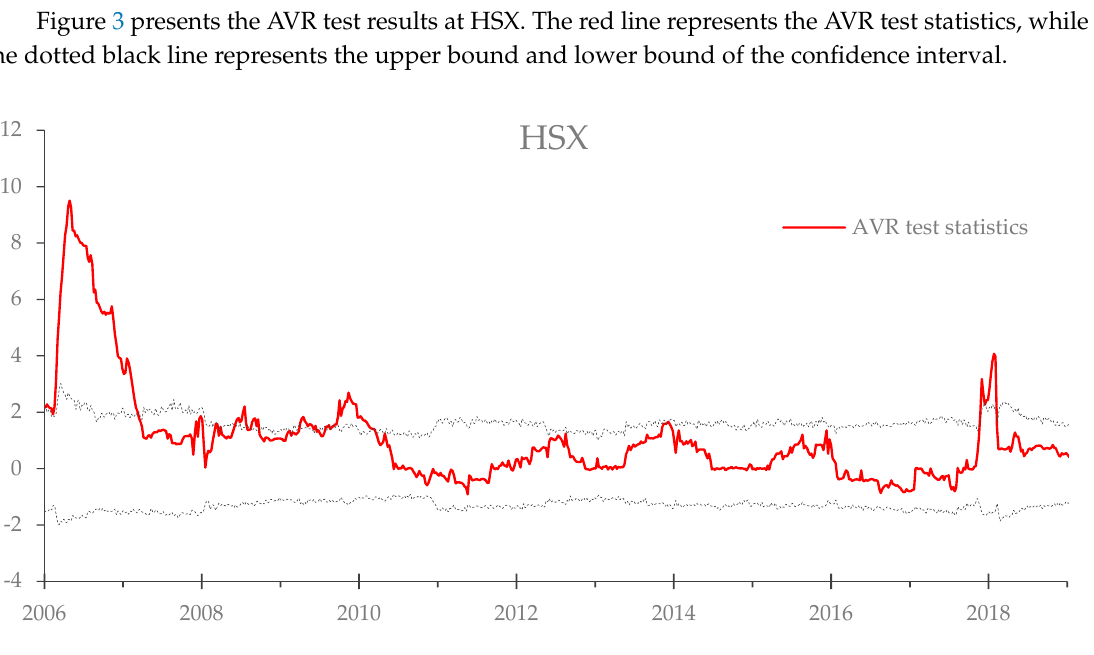
Figure 3. Automatic variance ratio (AVR) test results for HSX.